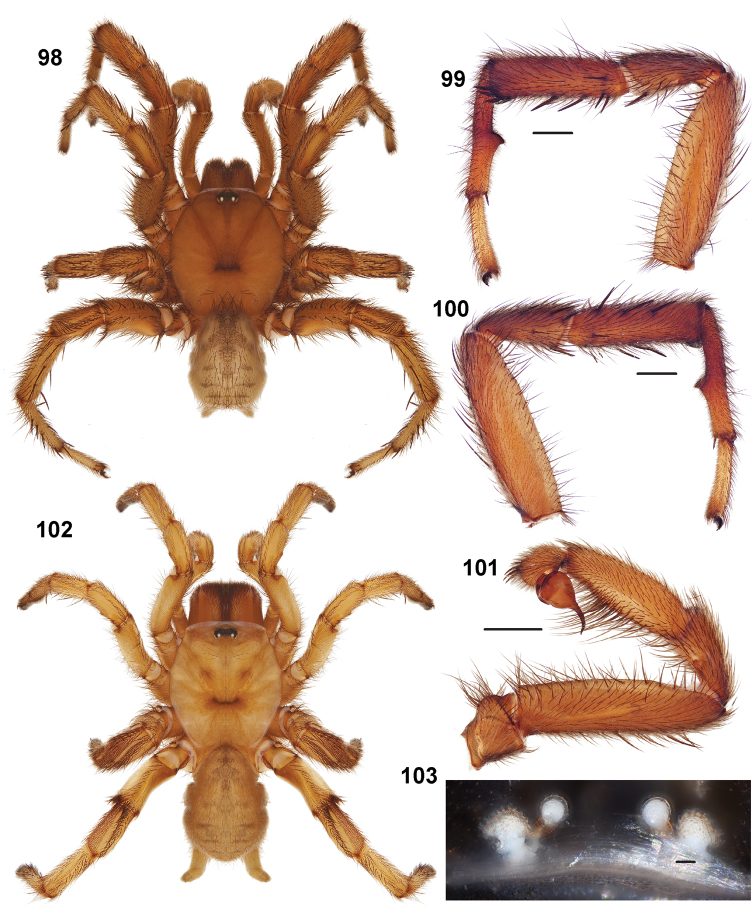
Aptostichus miwok Bond, 2008. 98 male habitus from Mendocino Co., Inglenook Dunes (AP1270) [805812] 99–101 male paratype (AP149) from San Francisco Co., Farallon Islands; scale bars = 1.0mm 99 retrolateral aspect, leg I [805801] 100 prolateral aspect, leg I [805797] 101 retrolateral aspect, pedipalp [805803] 102 female habitus from Mendocino Co., Inglenook Dunes (AP520) [805808] 103 spermathecae, female holotype (MY301) [805804]; scale bar = 0.10mm.